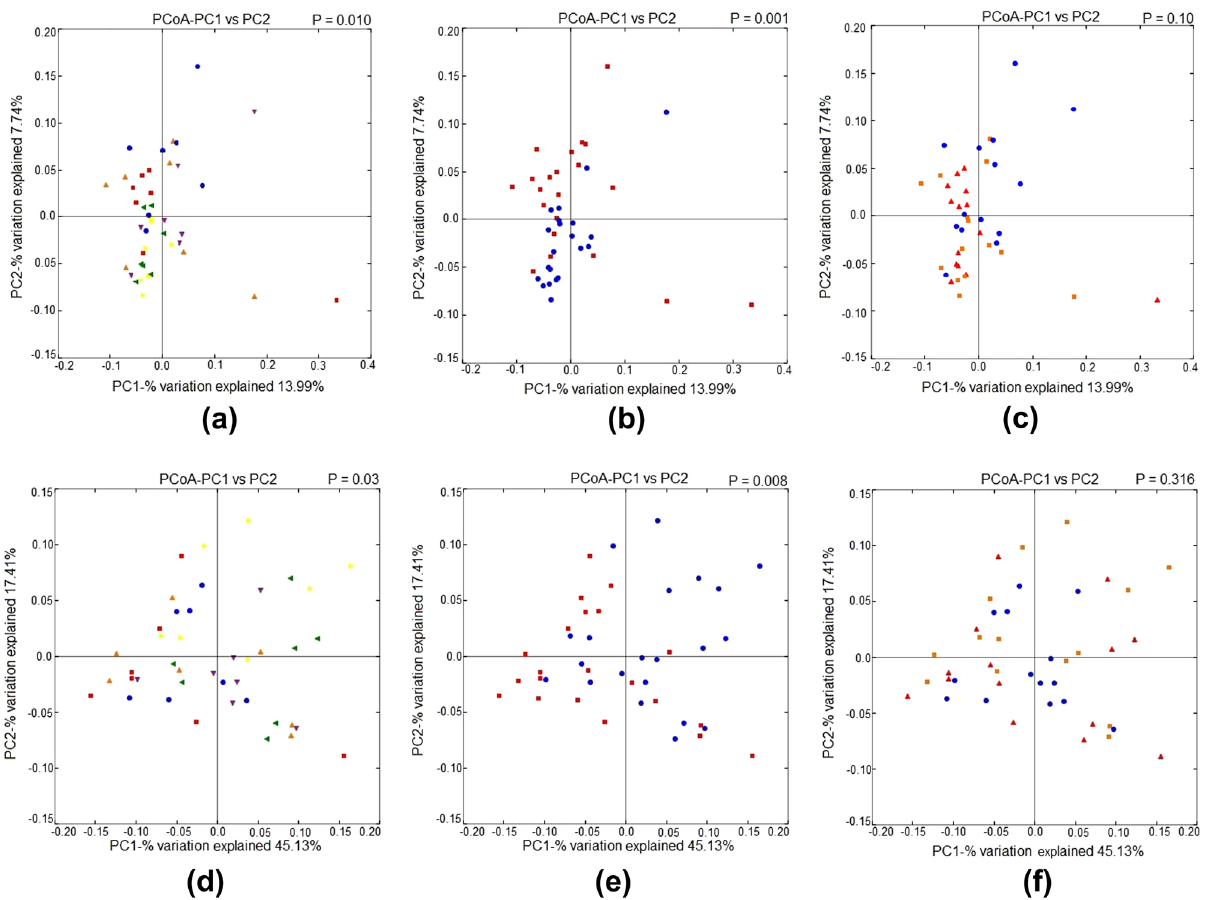
Figure 3. Effect of dietary steam-exploded pine particle supplementation on the beta-diversity of broilers reared under normal or cyclic heat stress conditions. Dietary treatments were 0, 1, and 2% SPP in diets respectively. The temperature of the rooms was maintained at either thermoneutral (NT; 21 °C) or cyclic heat stress (CHS; 31 °C; 6 h daily) for 7 days. Change in cecum microbiota based on unweighted and weighted UniFrac distances indicating interaction effect ( a and d ; green triangle indicates 0% NT, purple triangle indicates 1% NT and yellow triangle indicates 2% NT, red square indicates 0% HS, a blue circle indicates 1% HS and the orange triangle indicates 2% HS), heat stress effect ( b and e ; the blue circle indicates NT and red square indicates HS), dose–effect ( c and f ; red triangle indicates 0%, a blue circle indicates 1% and orange square indicates 2% dose of SPP)